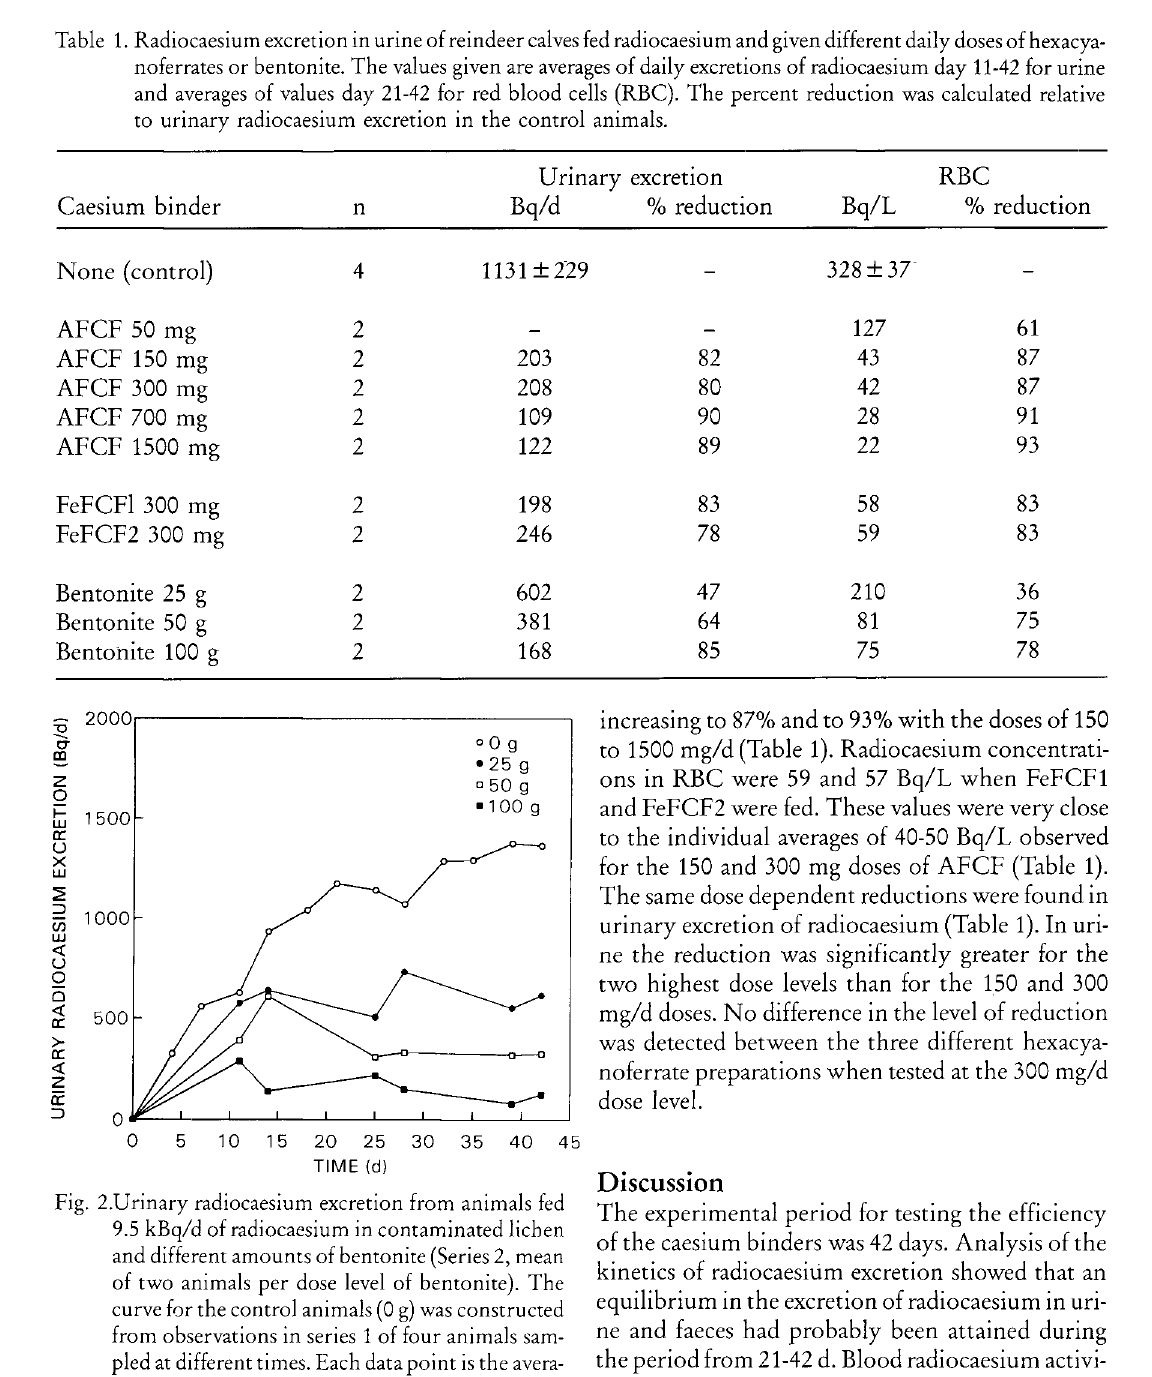
Table 1. Radiocaesium excretion in urine of reindeer calves fed radiocaesium and given different daily doses of hexacya- noferrates or bentonite. The values given are averages of daily excretions of radiocaesium day 11-42 for urine and averages of values day 21-42 for red blood cells (RBC). The percent reduction was calculated relative to urinary radiocaesium excretion in the control animals.